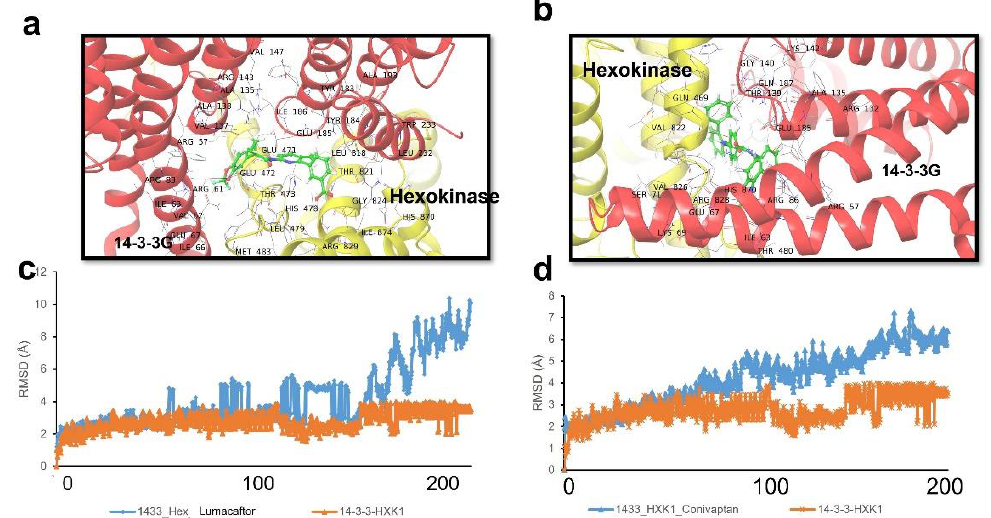
Figure 5. Protein aggregation or its sequelae are reduced by drugs that target the 14-3-3G::hexokinase interface. ( a , b ) Predicted binding sites of repurposed-drug candidates lumacaftor ( a ) and conivaptan ( b ), at the interface between hexokinase and 14-3-3G. ( c , d ) RMSD plots of the 14-3-3G:: hexokinase complex, as predicted in the absence (orange) or presence (blue) of lumacaftor ( c ) or conivaptan ( d ), simulated over 200-ns timespans.